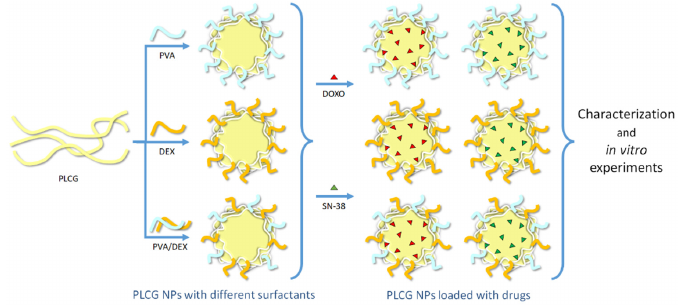
Scheme 1. Illustration of the polymeric components of the NPs (the light yellow, light blue and orange curved lines correspond to PLCG, PVA and DEX, respectively), of the drugs (the red and green triangles correspond to DOXO and SN-38, respectively) encapsulated within them and of the main steps of the work.